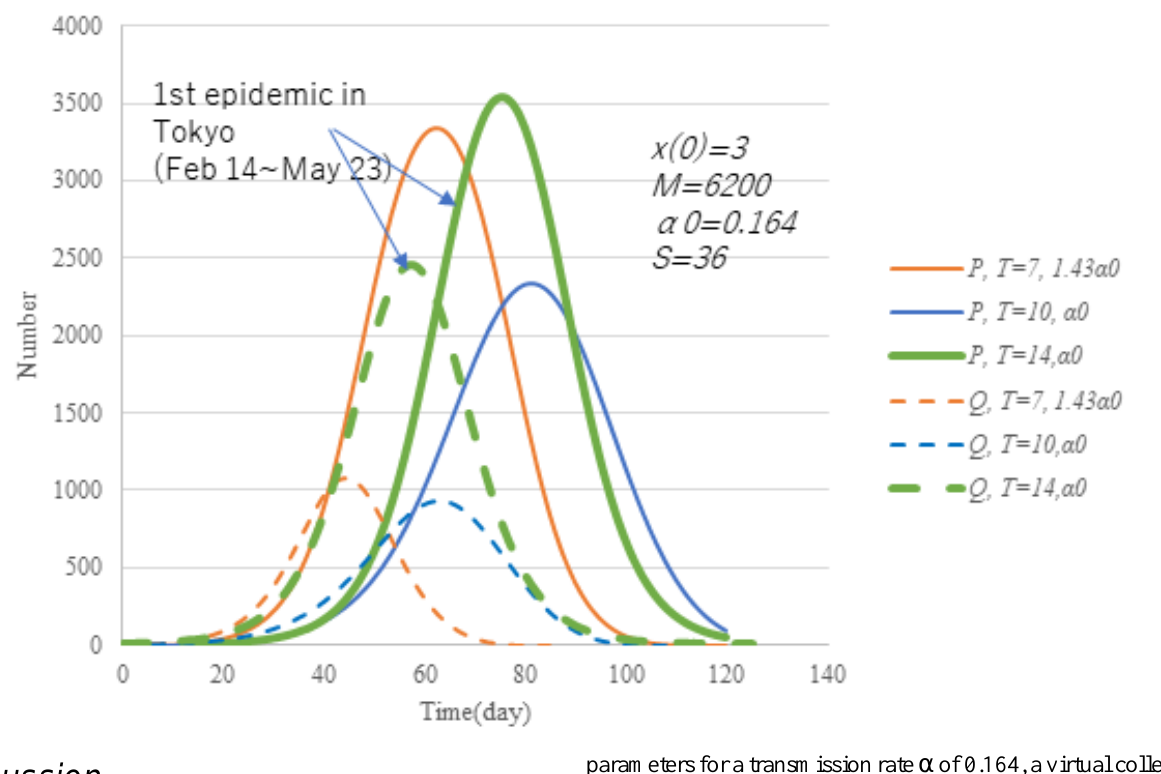
Figure 15. Effect of T on the number of inpatient and infectious cases at large under the condition of ( α T )=10 α 0. Model PART1 was applied with parameter values same as in Figure 3 except transmission rate α and time lag T . Solid lines represent the number of inpatients (P) and broken lines the number of infectious at large (Q). The reduction of T and an increase in α may provide a solution that reduces inpatient count and enhances economic